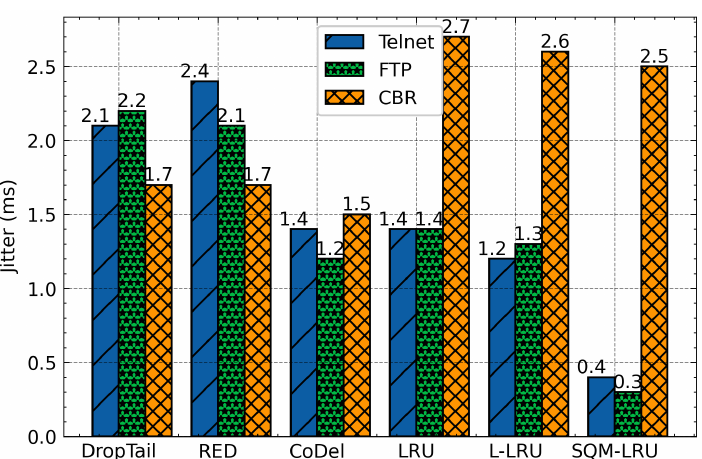
Figure 11. Average jitter